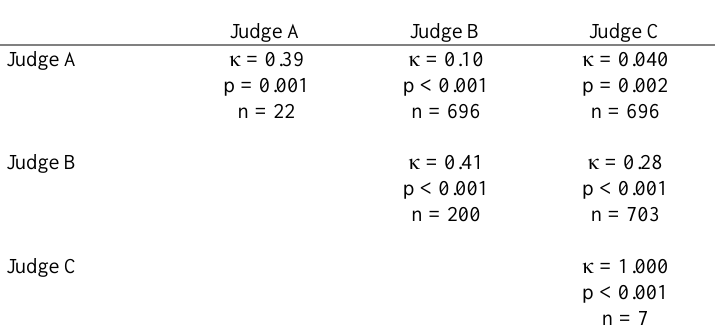
Inter-rater and Intra-rater Reliability of Whistle Similarity Scoring by Judges Judge A Judge B Judge C